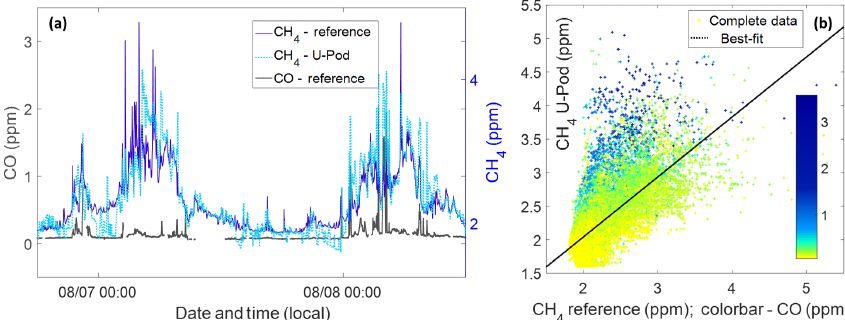
Figure 14. (a) Time series of methane and carbon monoxide data from the reference monitors and converted U-Pod sensor data. (b) Scatter plot of reference methane data ( x axis) vs. U-Pod methane data ( y axis) with the points colored by carbon monoxide vales. Together they further show the Figaro TGS 2600’s cross sensitivity to carbon monoxide, illustrating how many over predictions correspond to instances when CO is at or above 0.5ppm. Table 7. Explained variance of the Figaro TGS 2600 resistance values ( R/R 0 ) for parameter sets including different VOCs. Source of variation Set 1 Set 2 Set 3 Set 4 Set 5